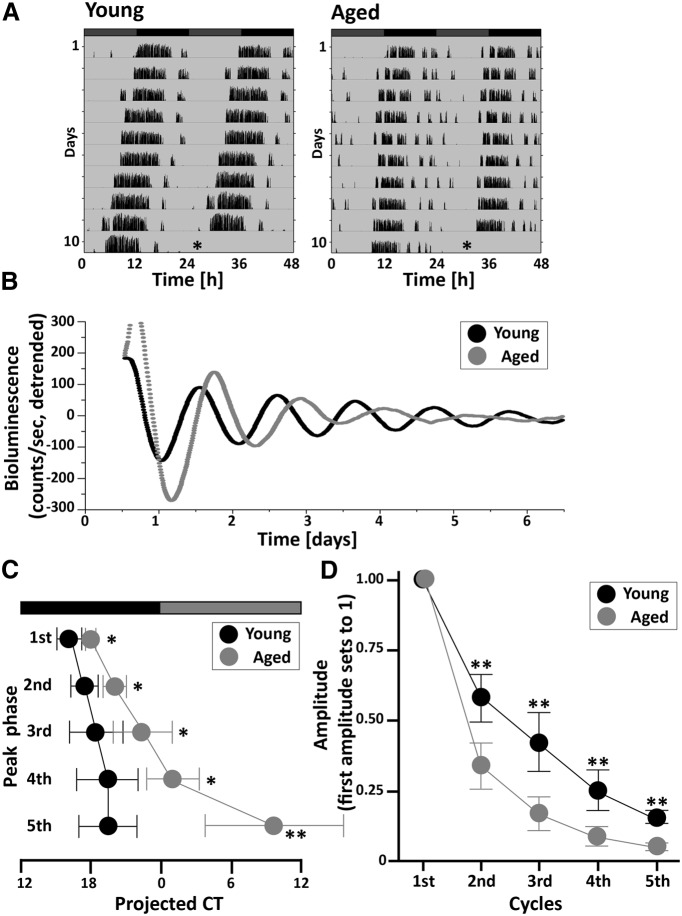
Effects of aging on PER2::LUC rhythms in SCN explants from mice maintained in DD. A, Representative double-plotted actograms of wheel-running activity in young and aged PER2::LUC mice maintained in DD. Asterisks indicate the timing of the killing of the animals. B, Typical examples of PER2::LUC rhythms of SCN explants from mice maintained in DD for 10 d, as measured by PMT. C, Phase map of peak PER2::LUC rhythms in the SCN. Each point represents the average peak of PER2::LUC rhythms in each cycle, plotted relative to the circadian time prior to the killing of the animals. D, Amplitude of PER2::LUC rhythms in the SCN. The amplitude of each oscillation was determined as the sum of the absolute value of the lowest and highest points (counts). Data are shown as the mean ± SD. n = 5 per group. *p < 0.05, **p < 0.01 for young vs. aged animals (Bonferroni post hoc comparison).